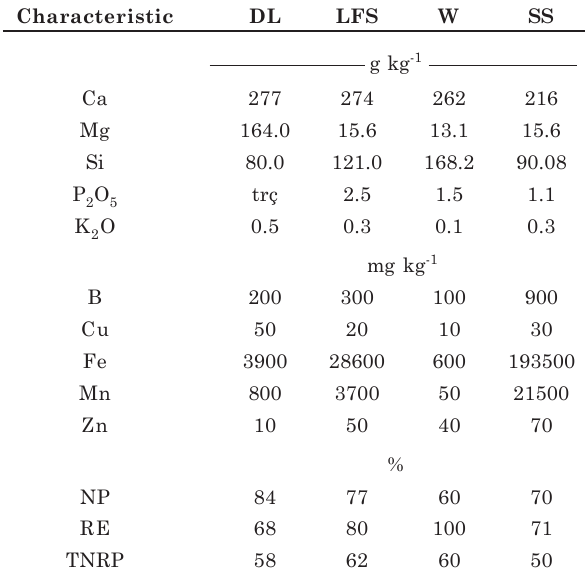
Table 2. Chemical analysis of acidity correctives: dolomitic lime (DL ), ladle furnace slag (LFS), wollastonite (W) and steelmaking slag (SS)